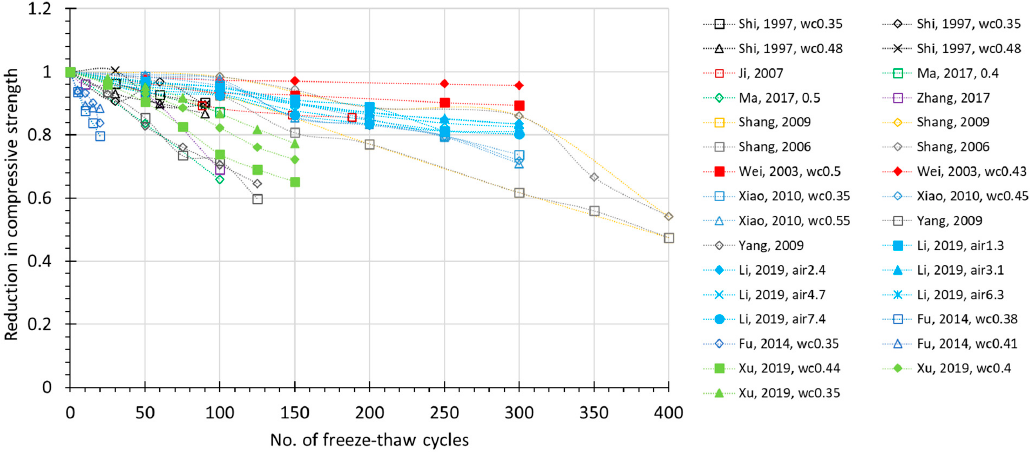
Figure 3. Relative dynamic elastic modulus (RDEM) during FTC for non-air-entrained concrete (for the same literature, wc —water to cement ratio; fa —ly ash added; sf —silica fume added).